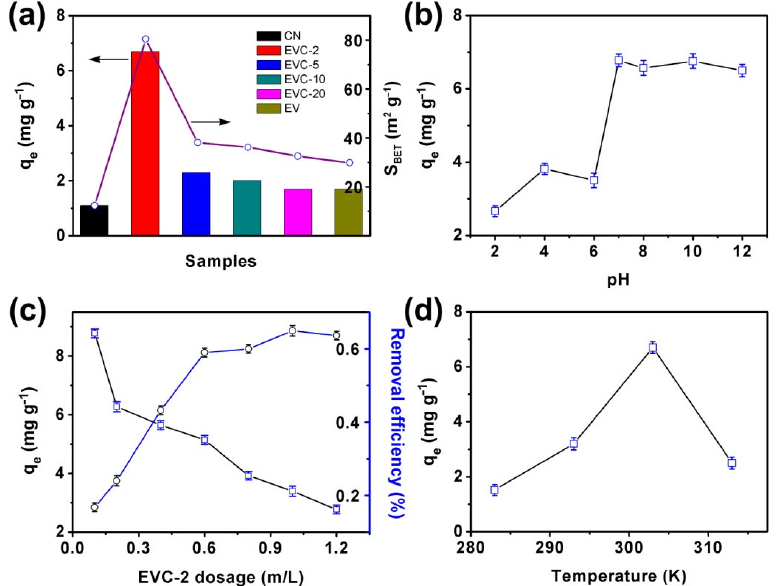
Figure 5. ( a ) Adsorption of MB on CN, EV, and EVCs: the impact of ( b ) pH, ( c ) initial dosage, and ( d ) temperature on the MB adsorption over EVC-2.